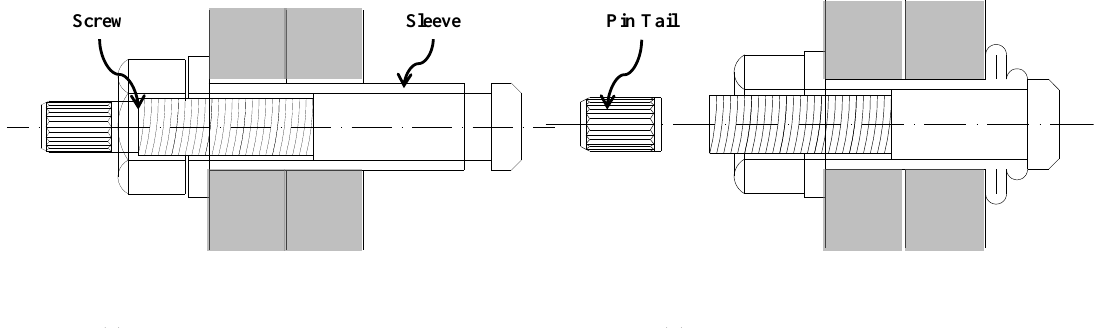
Figure 2. Module-to-module connection details.